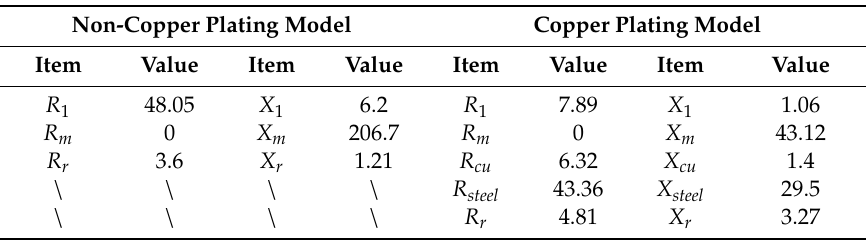
Table 3. Equivalent circuit parameters of non-copper and copper plating models (slip =